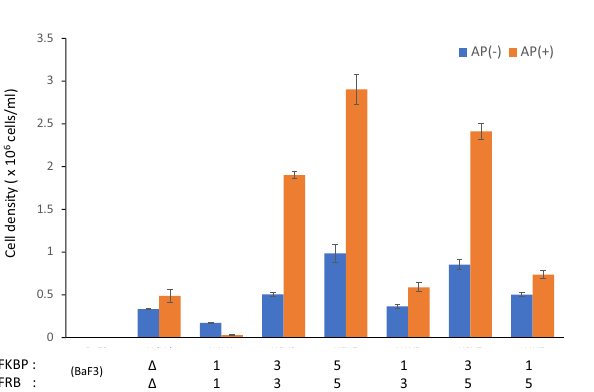
Figure 6. Cell proliferation properties of designer receptor-expressing cells. A cell proliferation assay was performed for the Ba/F3 transductants expressing the designer receptors analyzed in Fig. 5. Cells were seeded into 24-well plates at day 0 (1.0 × 10 5 cells/ml) and cultured in the medium with/without 50 nM AP21967. On day 3, cell number was counted by flow cytometry. Viable cell densities in triplicate cultures are plotted as mean ±